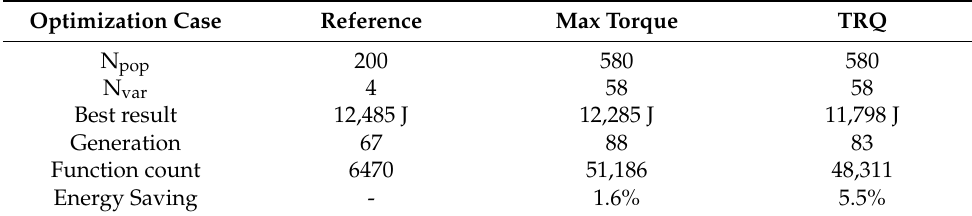
Figure 13. Track optimization results for Uni Track; ( a ) speed profile; ( b ) energy consumption. The optimization parameters and results are illustrated in Table 5. The best result of the Max Torque method is just slightly more favorable than the reference, while the TRQ optimization results in a 5.5% improvement compared to the reference optimization. Table 5. Optimization parameters and results for Uni Track. Optimization Case